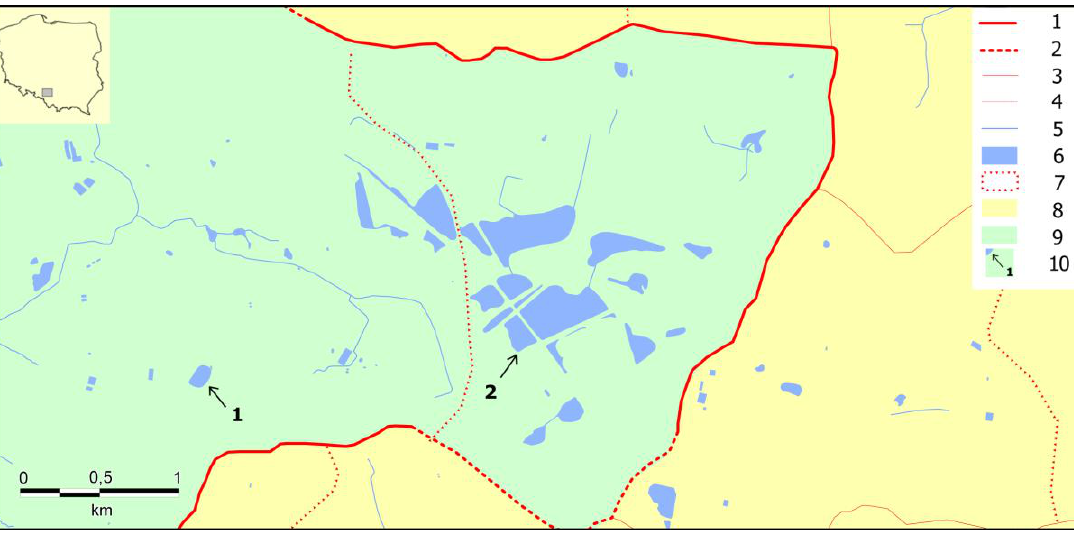
Fig. 1. The location of the water bodies within the hydrographical